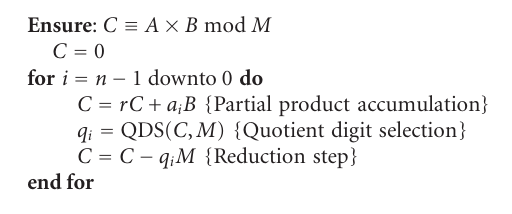
Algorithm 1: A Typical Example of Classical Modular Multiplica- tion.